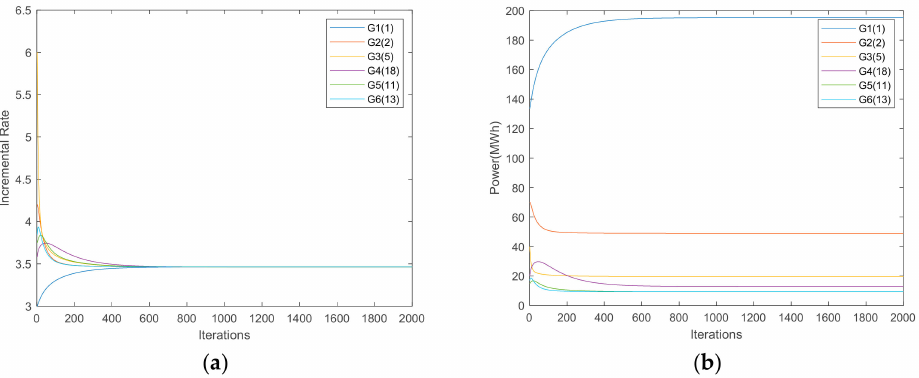
Figure 19. IEEE 30-bus test system. ( a ) The rate of micro-increase in fixed-time consistency at the random delay, ( b ) Fixed-time consistency of the power state at the random